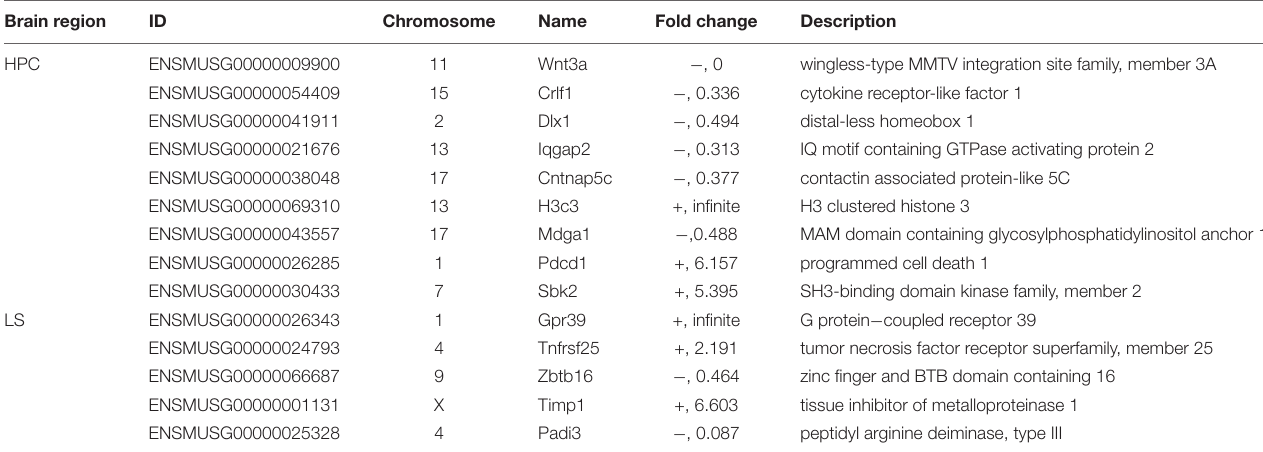
TABLE 1 | Representative dysregulated genes in HPC and LS of TLE